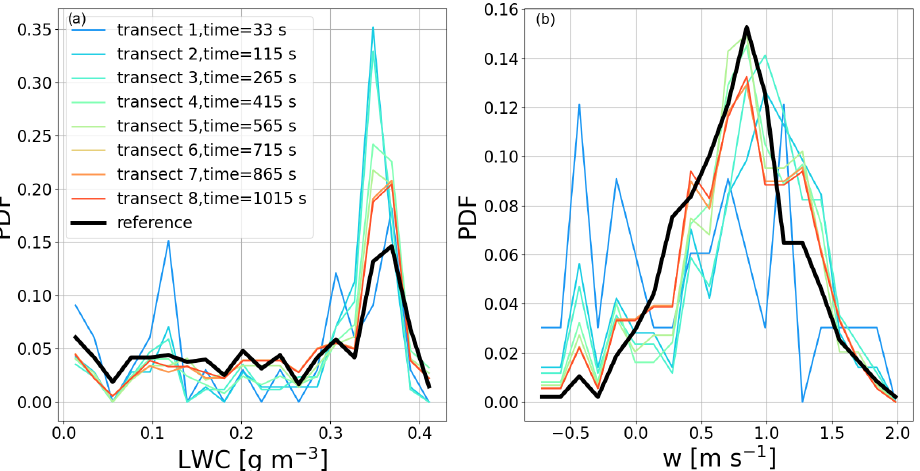
Figure 8. Reconstructed probability density function (PDF) of (a) LWC with time (color) compared to the reference of cloud N2 (black) at a height of 700ma.s.l. (b) Same for vertical